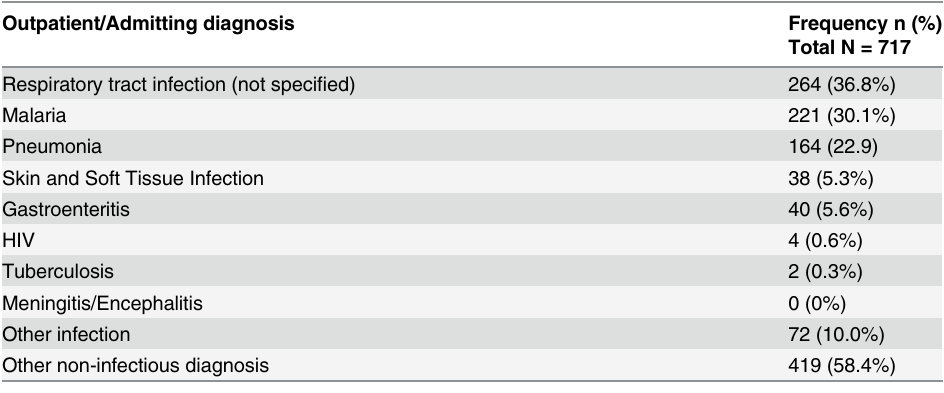
Table 2. Outpatient department